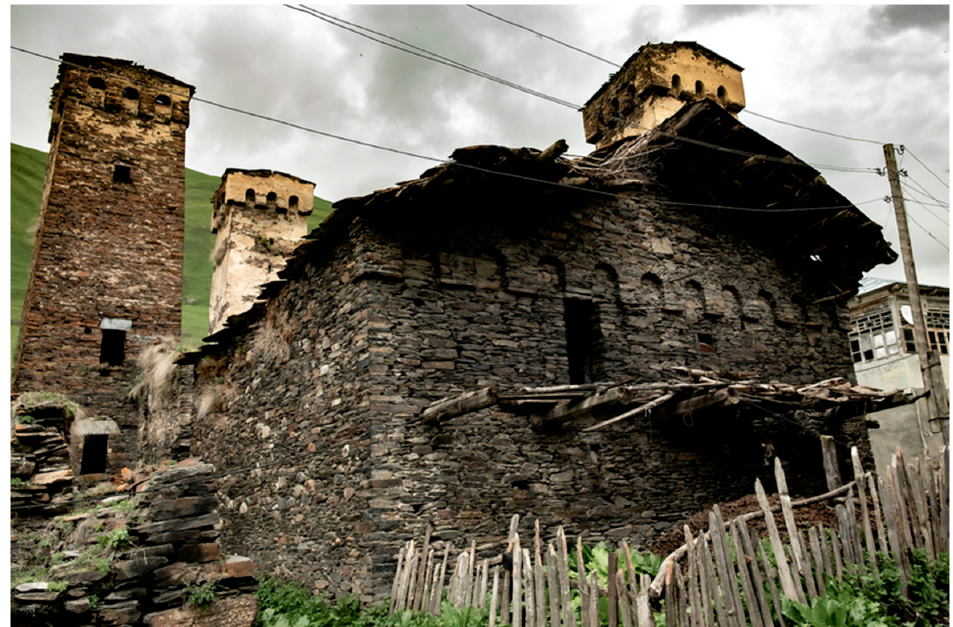
Figure 6. Dilapidated medieval building in Murkmeli, the bottom village of the village community of Ushguli; the owners of the historic building have no means to preserve it. As Murkmeli is not a World Heritage Site, the various Georgian governments have not invested in the preservation of its buildings (Applis 2019).